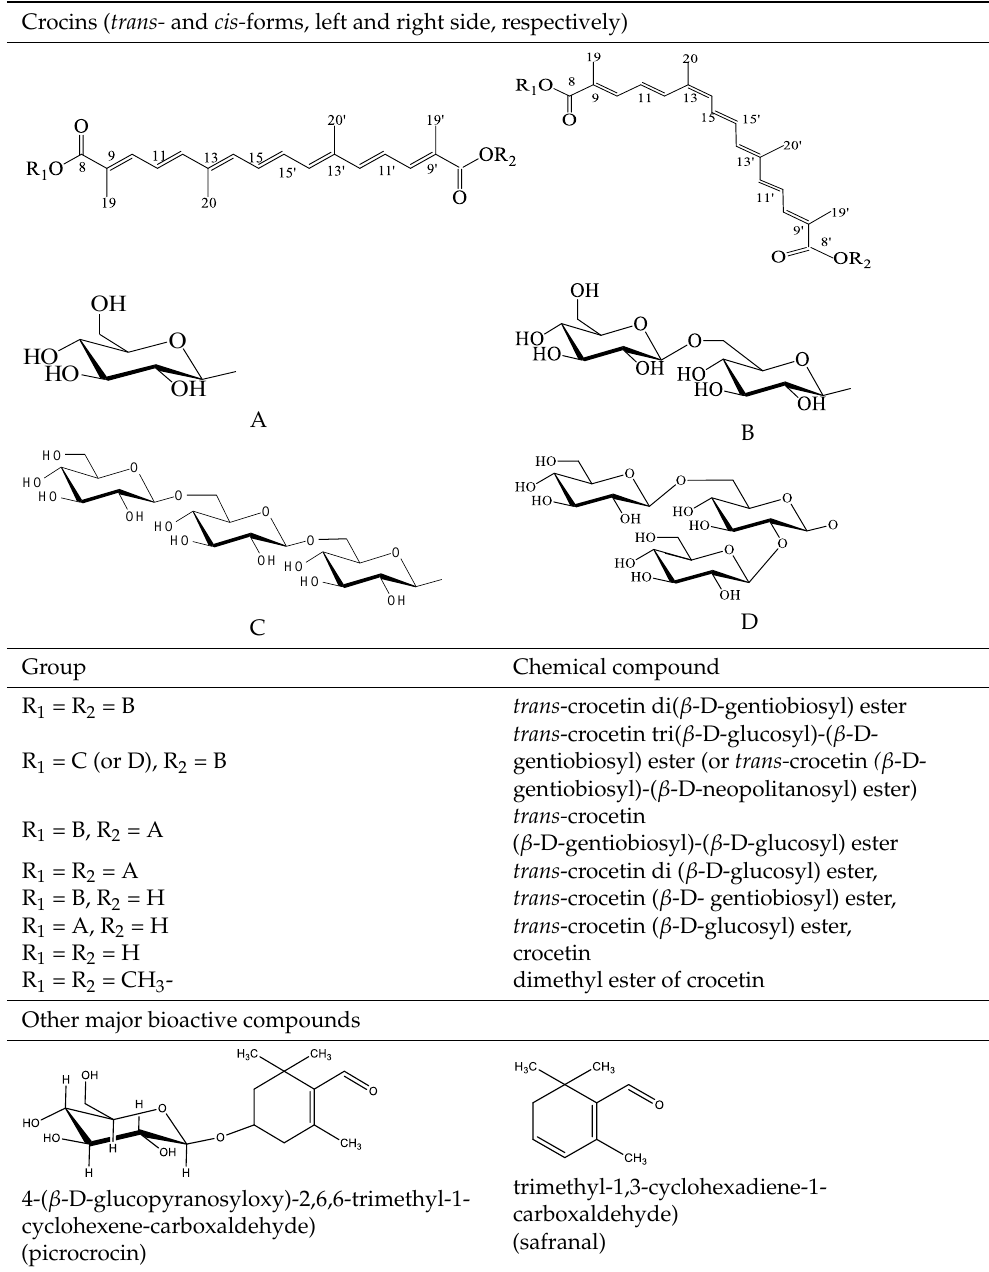
Table 1. Major bioactive apocarotenoids of saffron. Crocins ( trans- and cis- forms, left and right side, respectively)